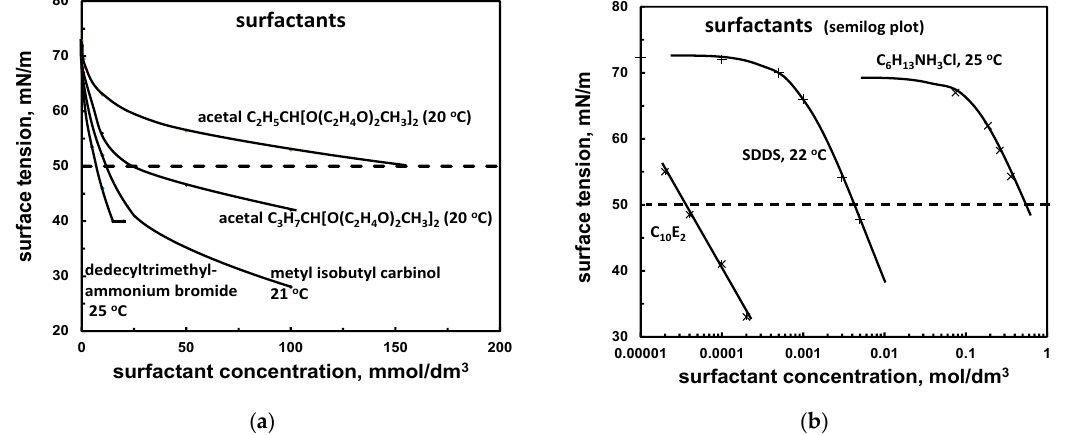
Figure 4. Surface tension of aqueous solution of selected surfactants and c σ 50 determination. ( a )